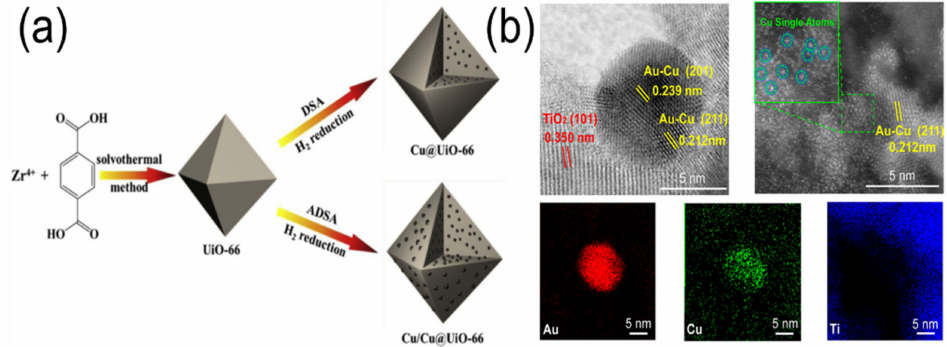
Figure 4. ( a ) Graphical representation of the Cu@UiO-66 and Cu/Cu@UiO-66 via DSA and ADSA syntheses (Reprinted from [87] with permission of Elsevier, 2019) and ( b ) HAADF-STEM images (up) and elemental mapping images of Cu0.8Au0.2/TiO2 (bottom) (Reprinted from [88] with permission of ACS,